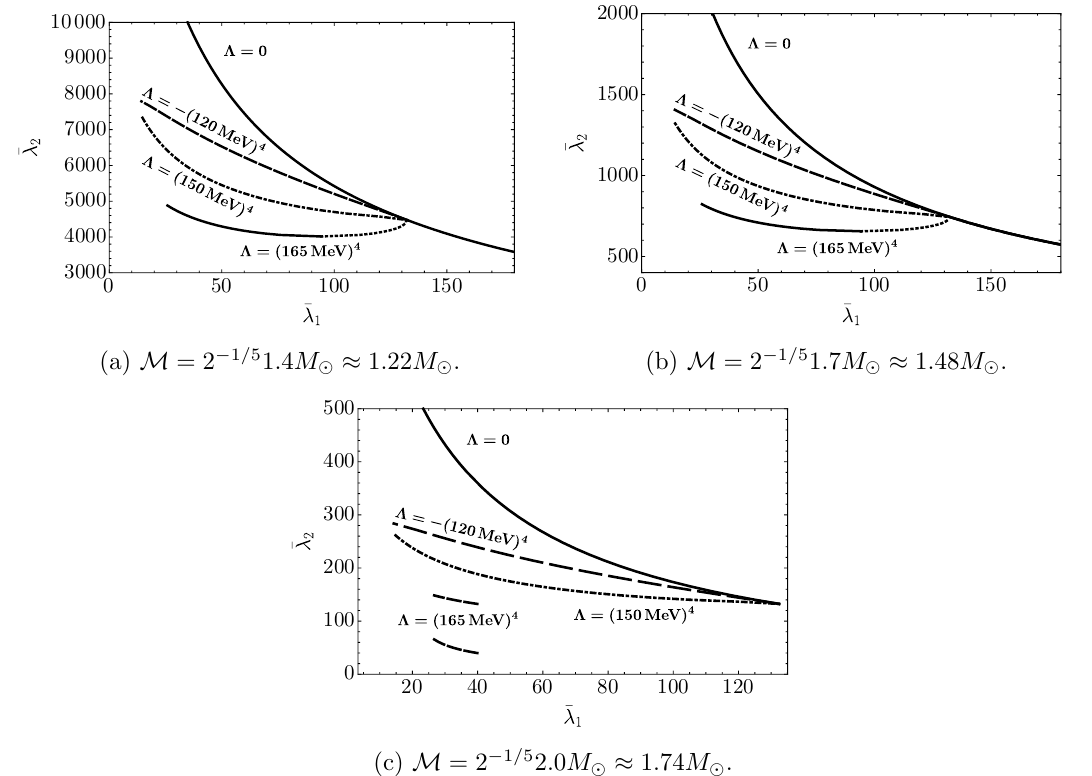
Figure 3. Tidal deformabilities for the Hebeler et al. parametrization with (cid:11) = 3. Each plot corresponds to a di(cid:11)erent chirp mass. Dotted parts of the curves with (cid:3) = (165 MeV) 4 correspond to unstable con(cid:12)gurations. In all cases, the deviation from the (cid:3) = 0 curve is